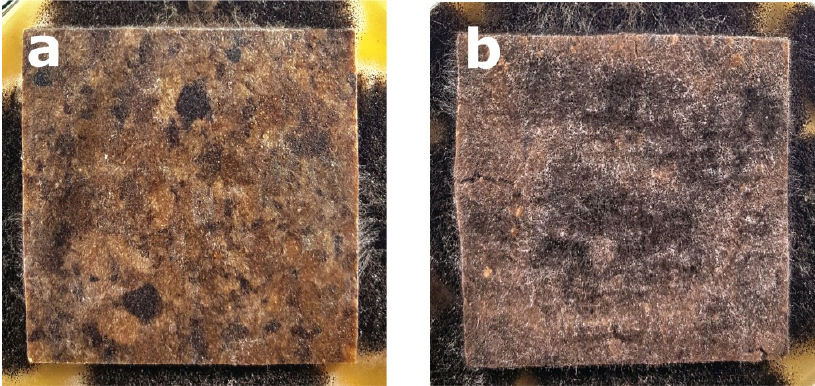
Figure 6. Example of mold growth ( Aspergillus niger Tiegh) after 7 days of exposure of composite samples with small particle sawdust filler of 60%, based on a matrix: ( a ) HDPE; ( b ) PLA.